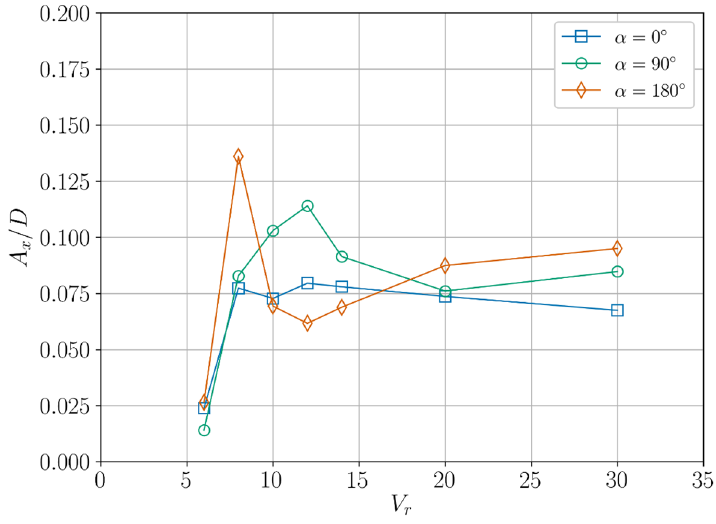
Figure 16. Inline response amplitude of FOWT platform under different current incidence.